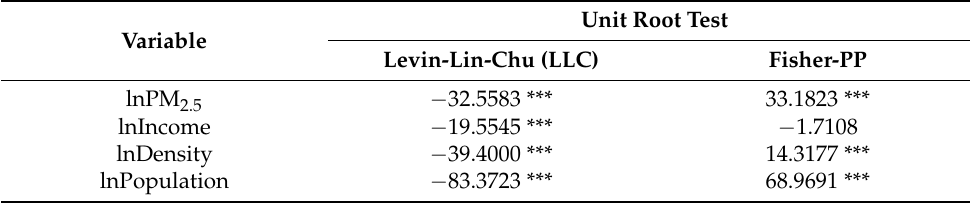
Table 2. Results of panel unit root tests.